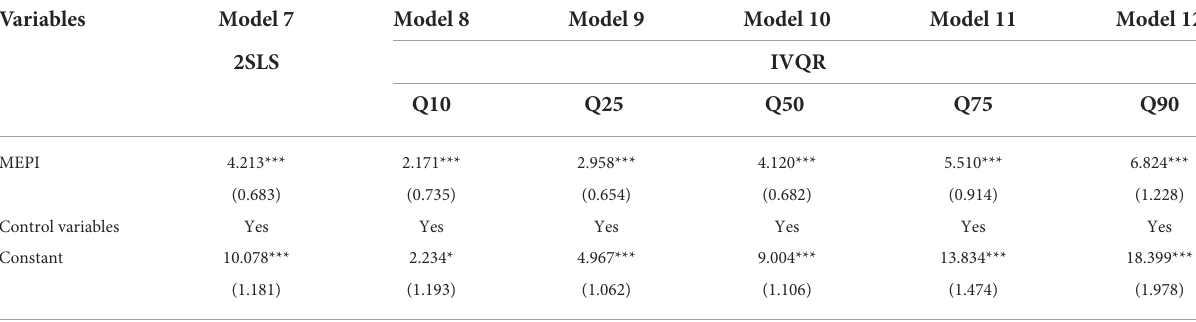
TABLE 4 Estimation results of instrumental variable regression models.